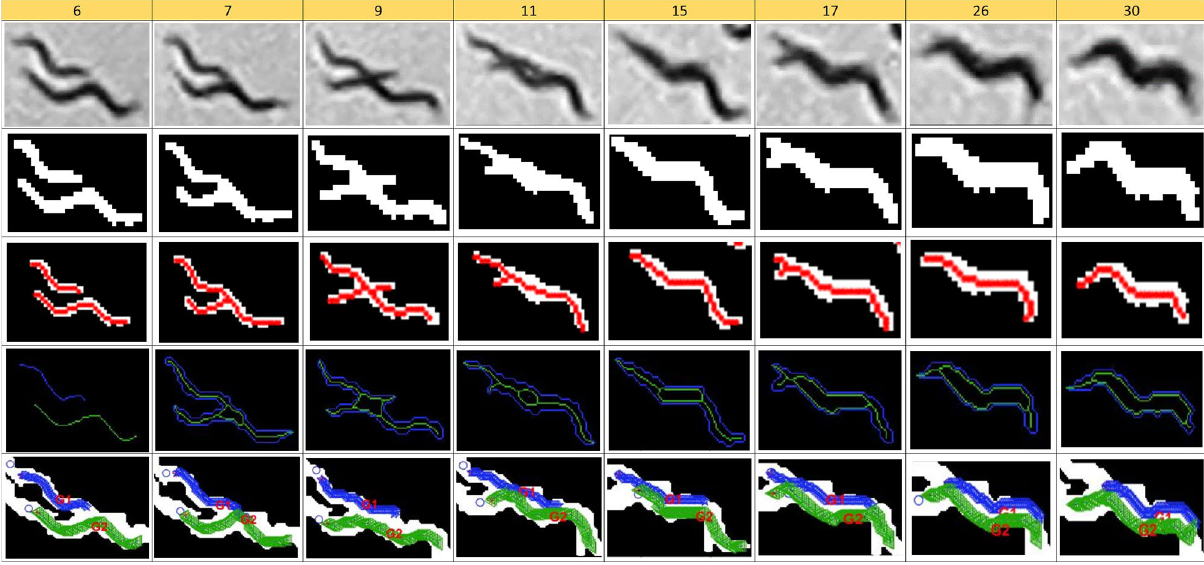
Figure 12. Tracking sequence comparison with both automatic methods. First row: original images; Second row: segmented images; Third row: Classic method skeletons; Fourth row: Proposed method skeletons; Fifth row: Best solutions from new